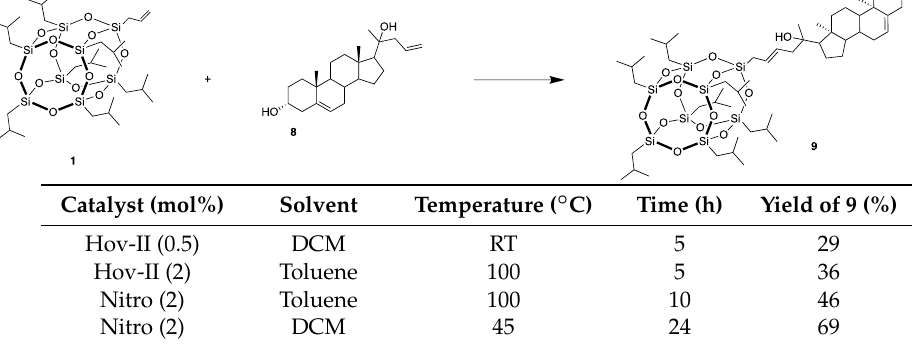
Table 3. Cross metathesis of allyl-POSS 1 with derivative of pregnenolone 8 .